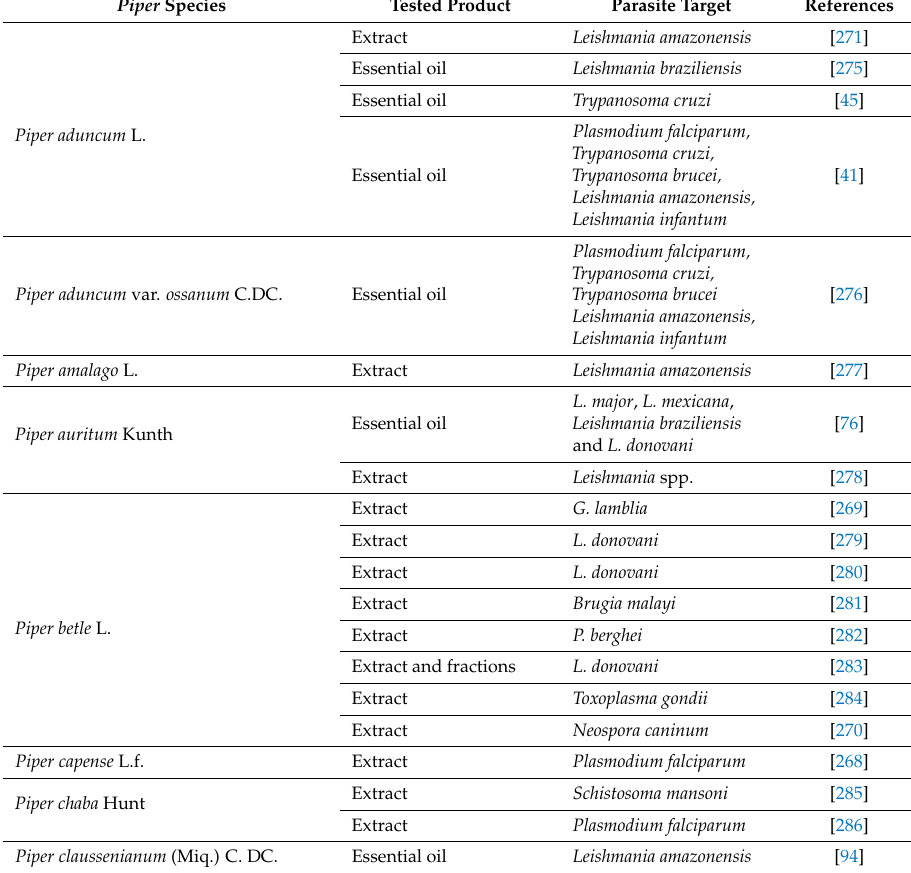
Table 29. Piper plants with reported activity on parasite of medical